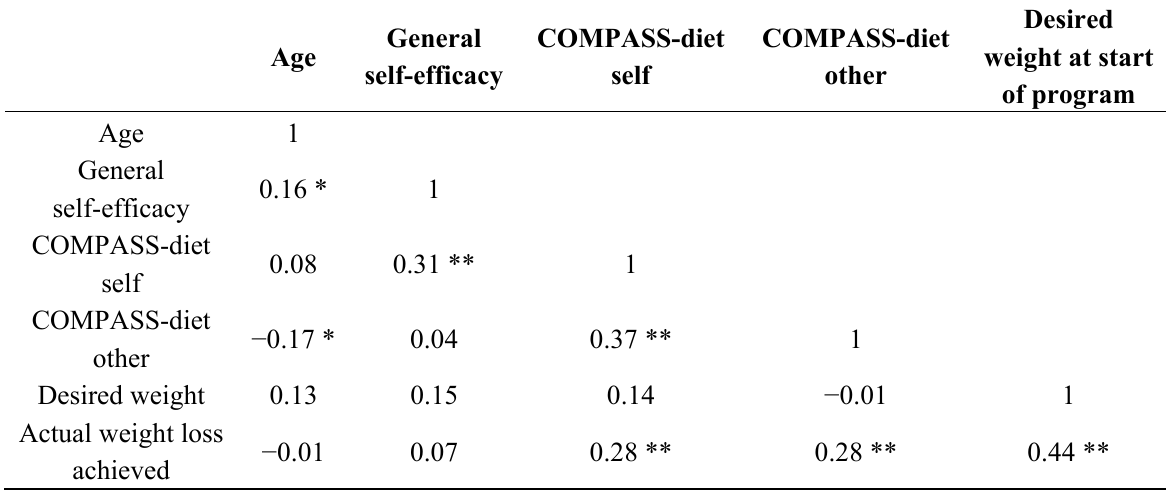
Table 2. Pearson correlations between participants age, self-efficacy, self or other rated compliance praxis-diet (COMPASS-diet) score, desired and actual weight loss.